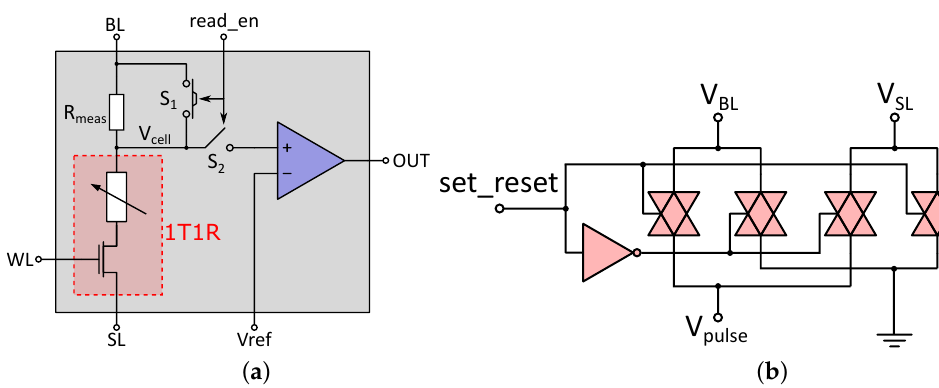
Figure 4. Components of the memory block: ( a ) memory cell, ( b ) set_reset switch. Table 2. RRAM cell state resistances and read